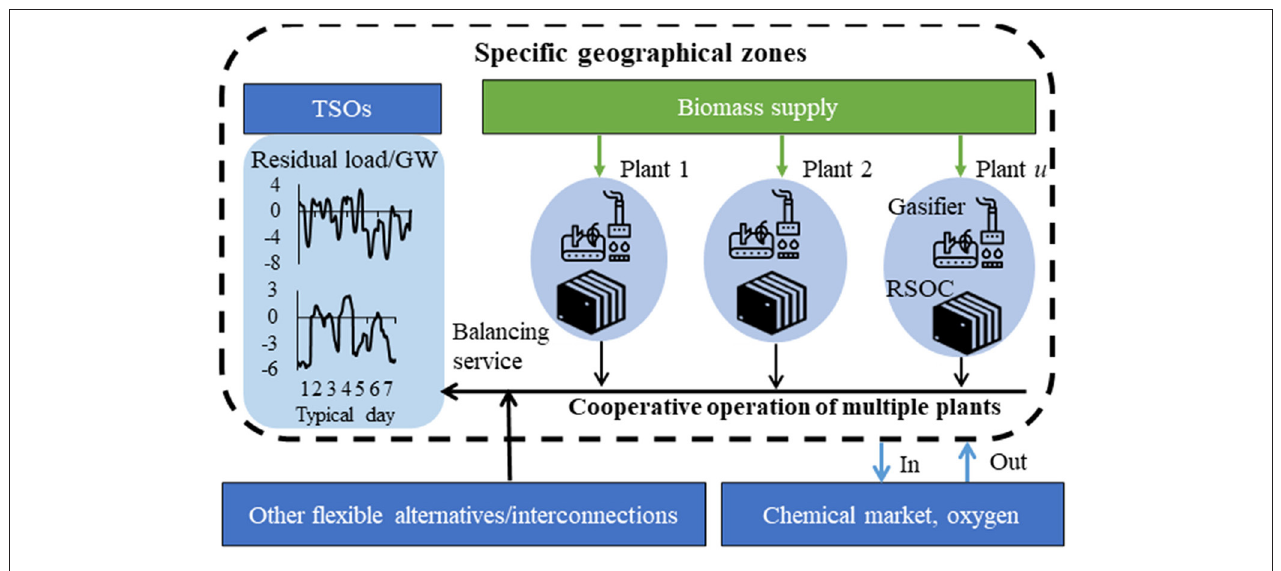
FIGURE 1 | Grid balancing services provided by the W2G